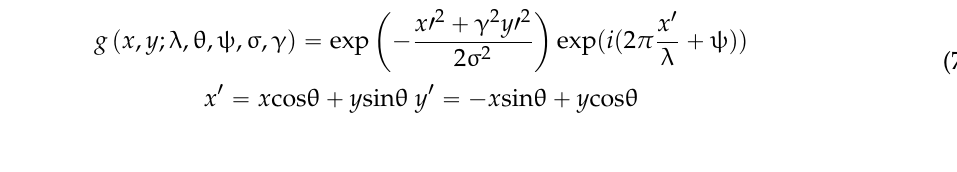
Figure 5. The results of mean and standard deviation of contrast feature extracted from 50 zebra crossing samples (red crosses) and 50 background samples (blue crosses) based on the DoG filtered images at different scales. ( a ) Mean ( G 1.5 ´ G 1.0 ); ( b ) Standard deviation ( G 1.5 ´ G 1.0 ); ( c ) Mean ( G 2.0 ´ G 1.5 ); ( d ) Standard deviation ( G 2.0 ´ G 1.5